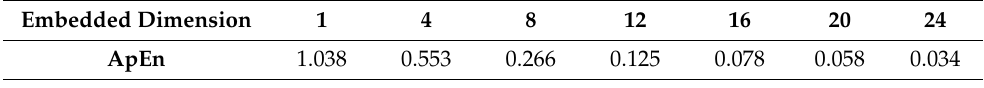
Table 1. Approximate entropy. Embedded